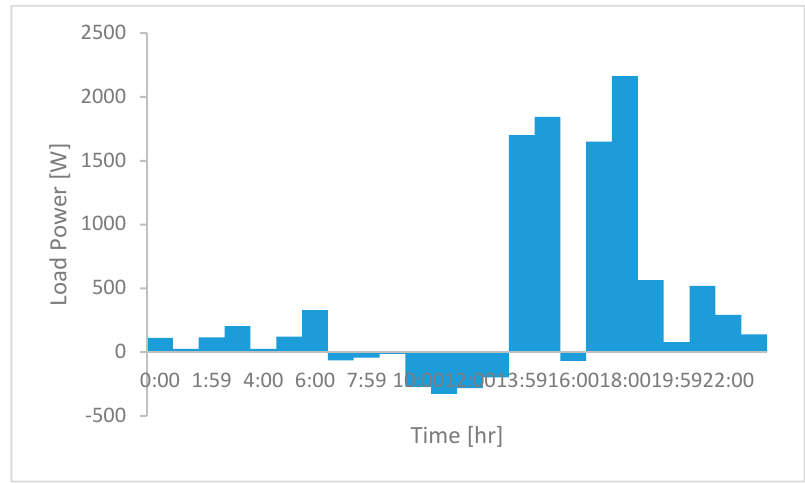
Figure 12. Load profile of a sample customer with grid-connected PV.